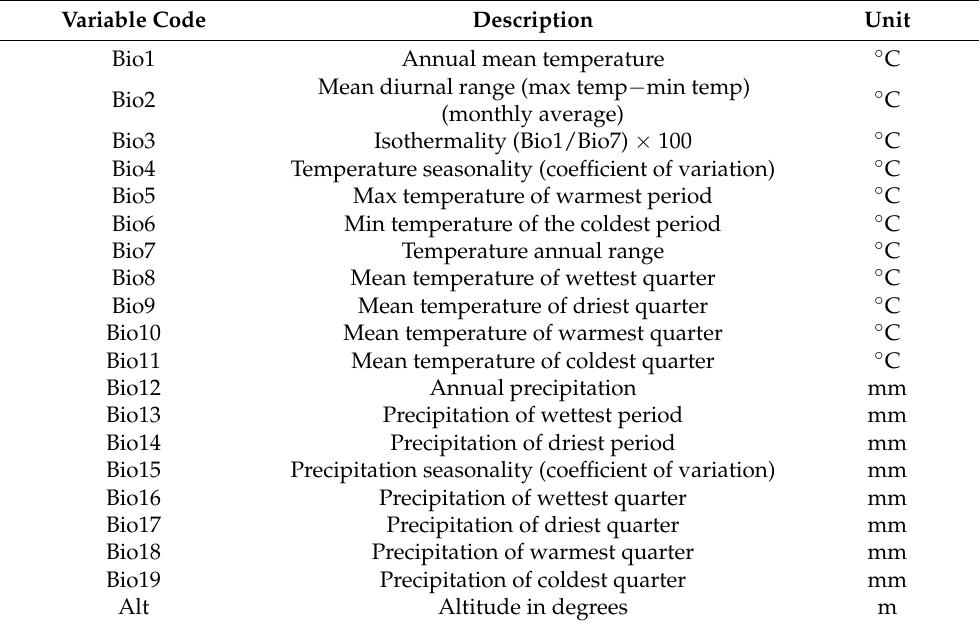
Table 1. Environmental and topographical variables used in the distribution modelling process of Spogostylum ocyale .